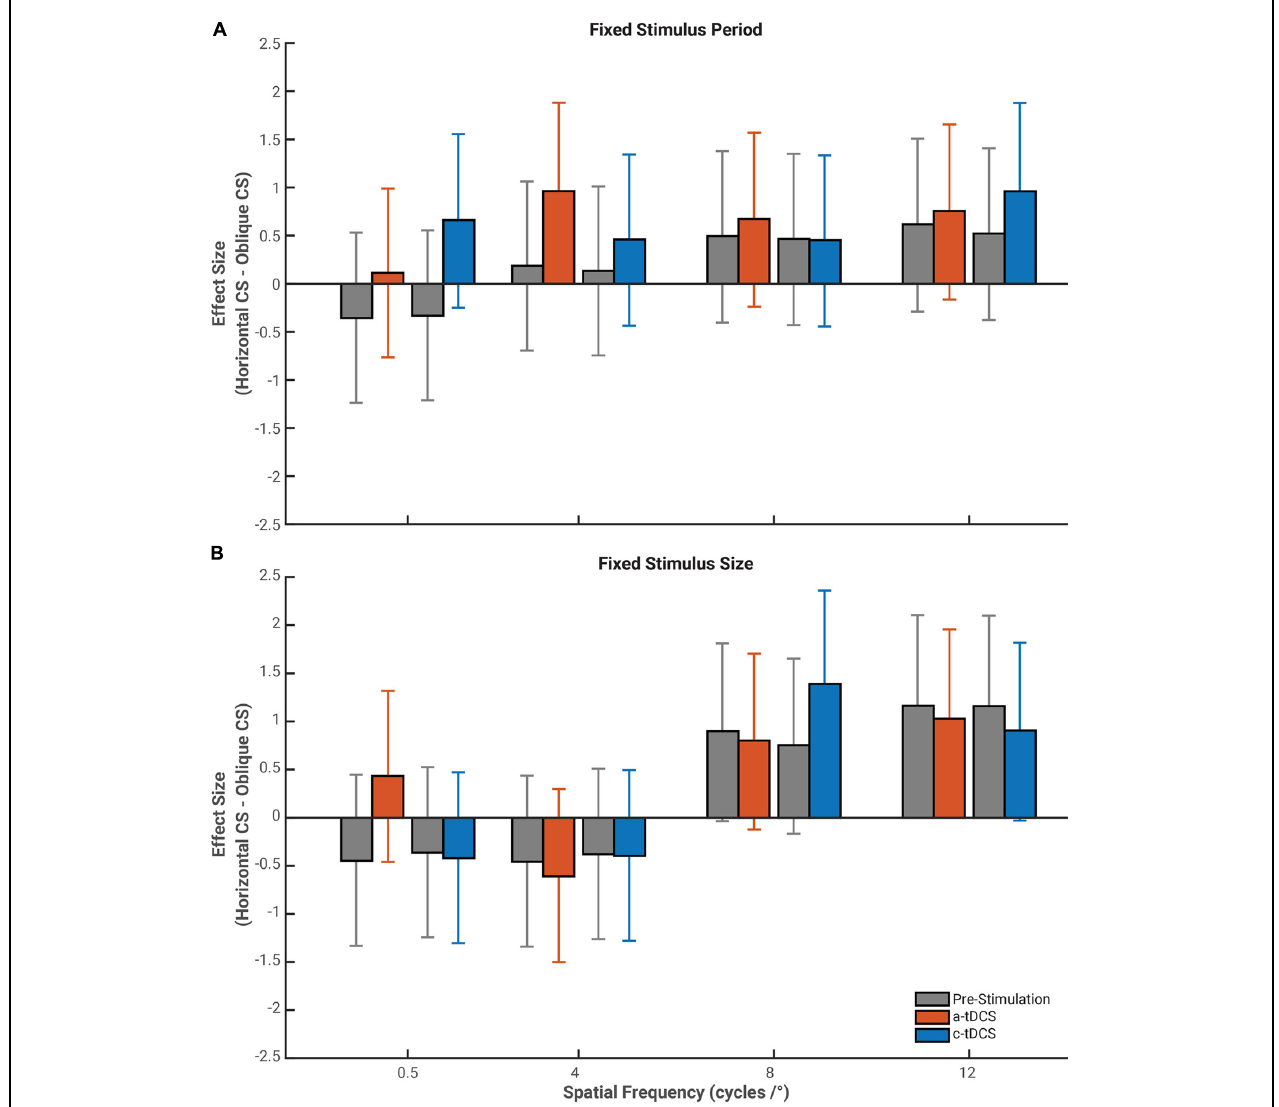
FIGURE 5 | Effect size of the mean difference between contrast sensitivity measured with horizontally orientated gratings and oblique orientated gratings. Gray bars represent the respective pre-stimulation baseline for either a-tDCS (red) or c-tDCS (blue) contrast sensitivity difference between horizontal and oblique gratings for stimuli of a fixed period (A) and fixed size (B) . We do find a-tDCS to increase the difference between contrast sensitivity measured to horizontal gratings and that of oblique gratings at a spatial frequency of 4 cycles/ ◦ and for c-tDCS to have a similar effect at a spatial frequency of 12 cycles/ ◦ . Error bars represent the exact 95% confidence interval for the mean difference effect